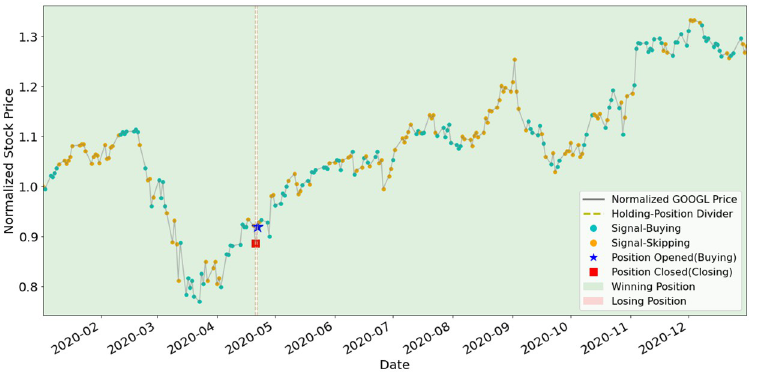
Fig 13. Signals and position-holding of GOOGL’s